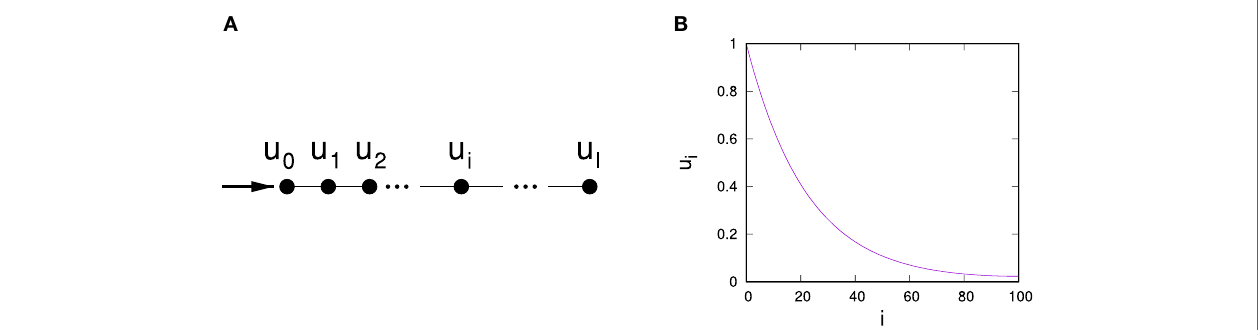
FIGURE 7 | Illustration of a chain network with control targeted at node 0 at the left end (A) and dependence of the average stationary vote shares u i depending on the distance i to the directly controlled node (B) for a chain of length 100 and q = 0.01 calculated based on equation